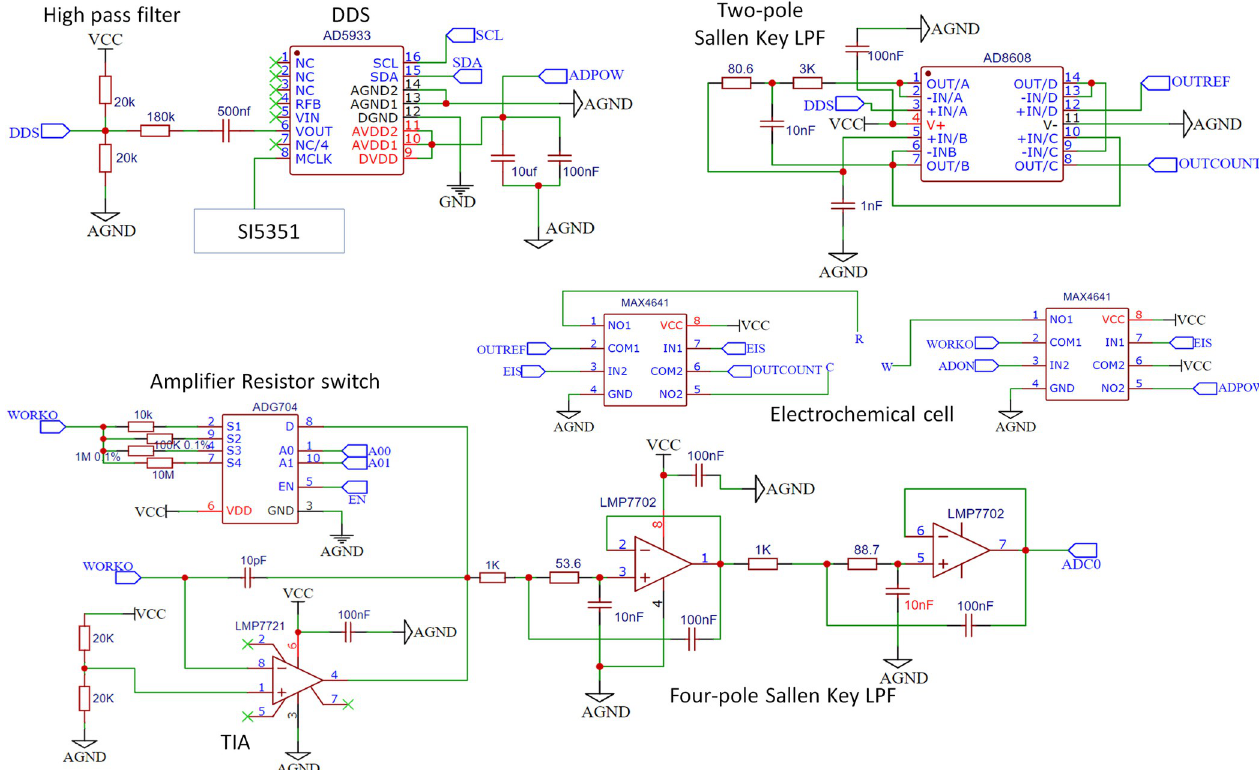
Fig 3. Potentiostat circuit with TIA circuit. Analog switches (MAX4641 and ADG704) are controlled by Teensy LC (not shown) and isolate the electrochemical cell. The TIA gain is controlled by one of four resistors selected by the ADG704 switch.